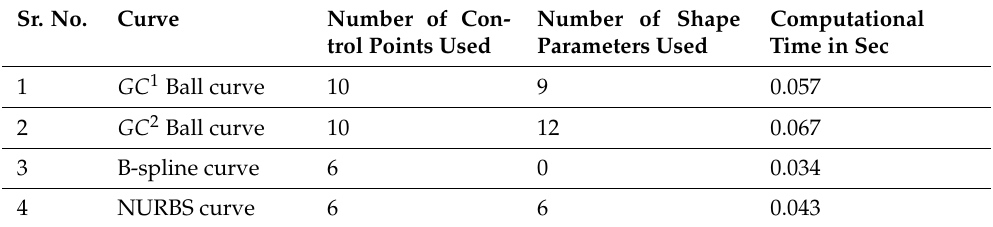
Table 2. Comparison of spline curves with three curve segments. Sr. No.